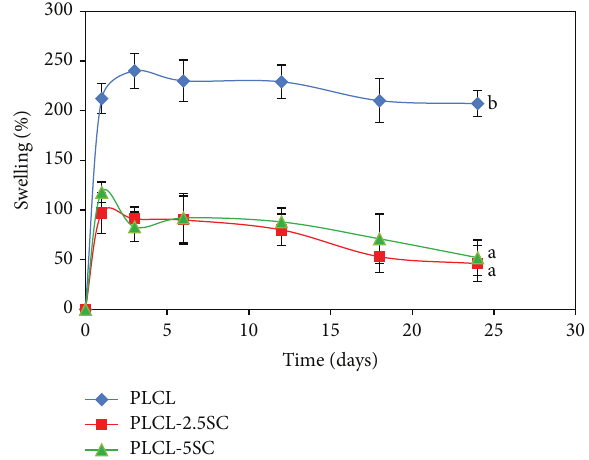
Figure 3: Swelling percentages of the PLCL-SC membranes over time. Statistical difference is indicated by lowercase letters (a, b) ( 𝑝 ≤ 0.05